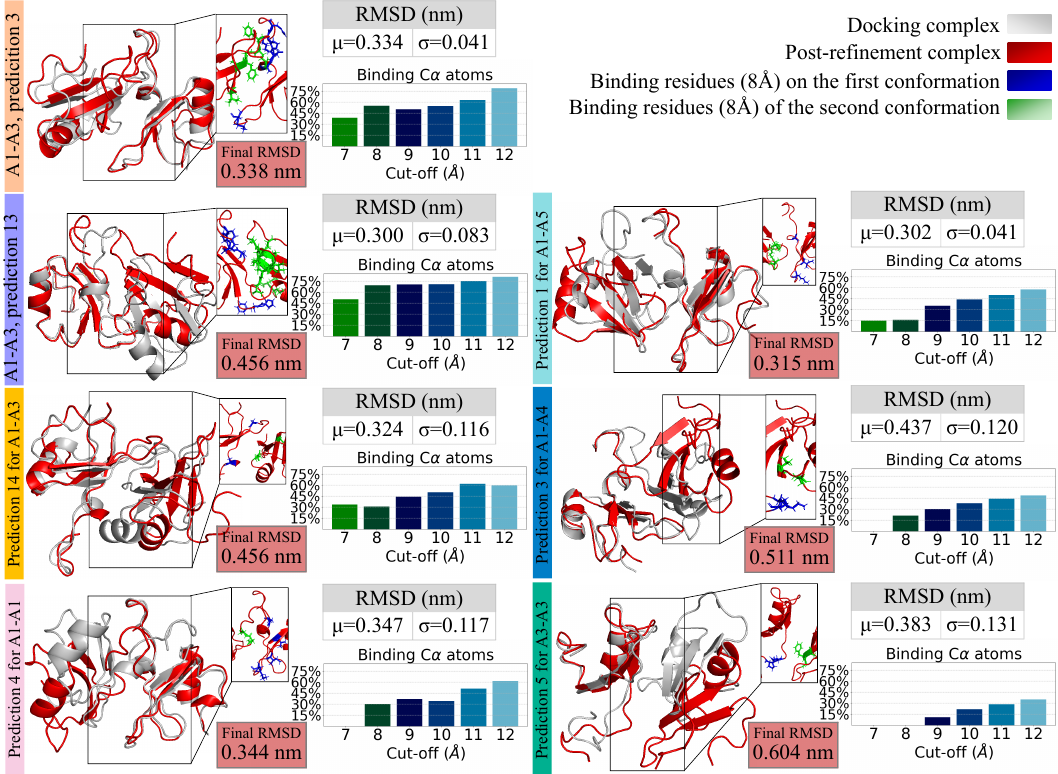
Figure 6. Comparison between docking complexes before and after the MD simulation. Cartoon representation of each of the seven Zernike-selected docking complexes (grey) and of the corresponding structure obtained after a MD simulation of 20 ns (red). Zooms display the binding residues on the first (blue sticks) and second (green sticks) conformation after the MD simulation. For each complex, the mean ( µ ) and standard deviation ( σ ) of the RMSD during the simulation (excluding the first two ns) are reported. Light-red boxes show, instead, the RMSD value of the structure at the end of the simulation. A bar-plot with the percentage of the C α binding atoms in the docking complex that are preserved at the end of the simulation (as a function of increasing cut-off distance) is reported as